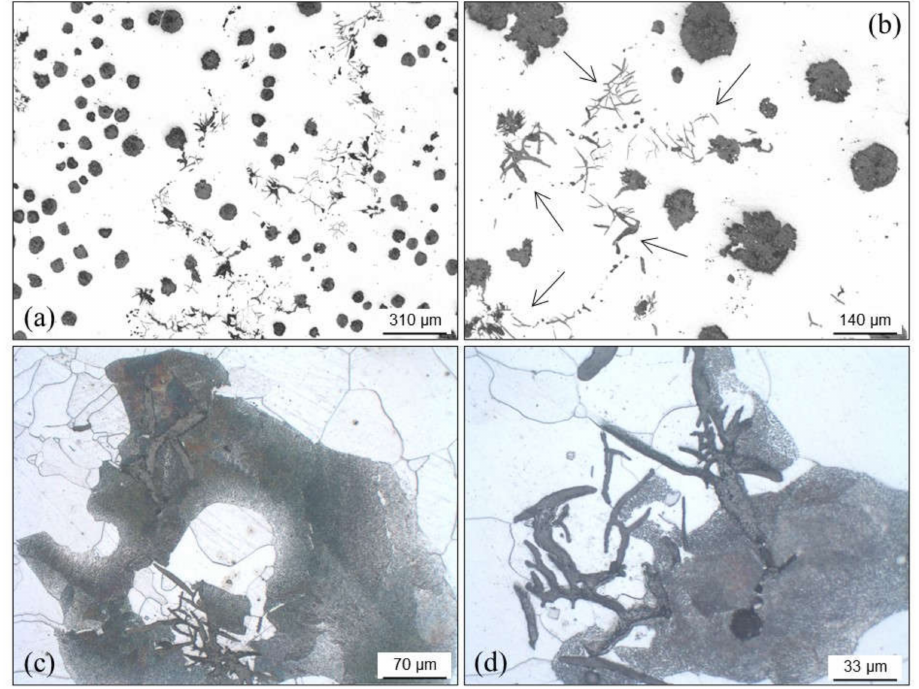
Figure 81. Spiky graphite found in a ductile iron casting solidified in about 60 min: views at different magnification in unetched samples ( a , b ) and in etched ones ( c , d